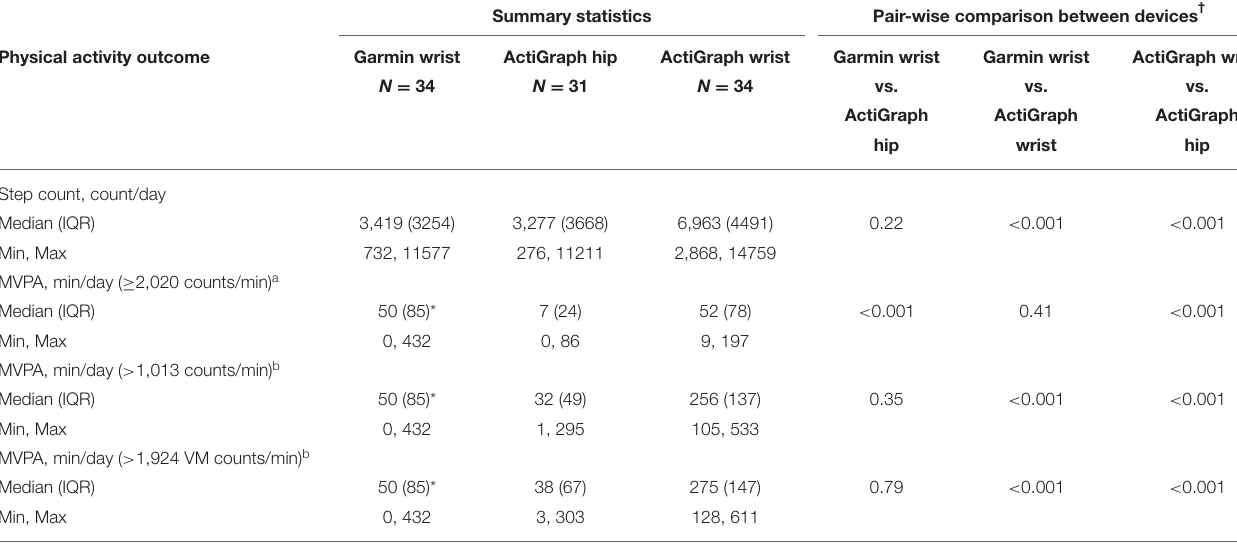
TABLE 2 | Daily steps and moderate vigorous physical activity difference between Garmin and ActiGraph devices. Summary statistics